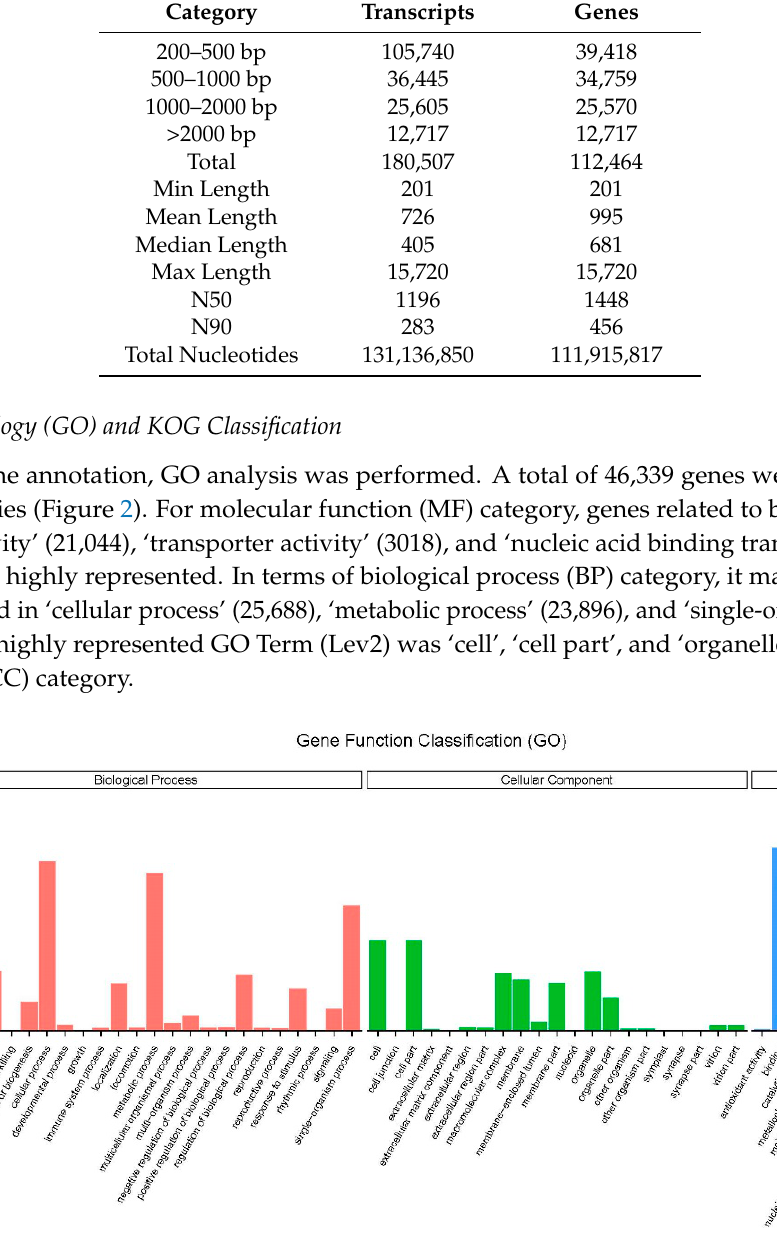
Table 2. Length distribution of the transcripts and genes clustered from the de novo assembly.